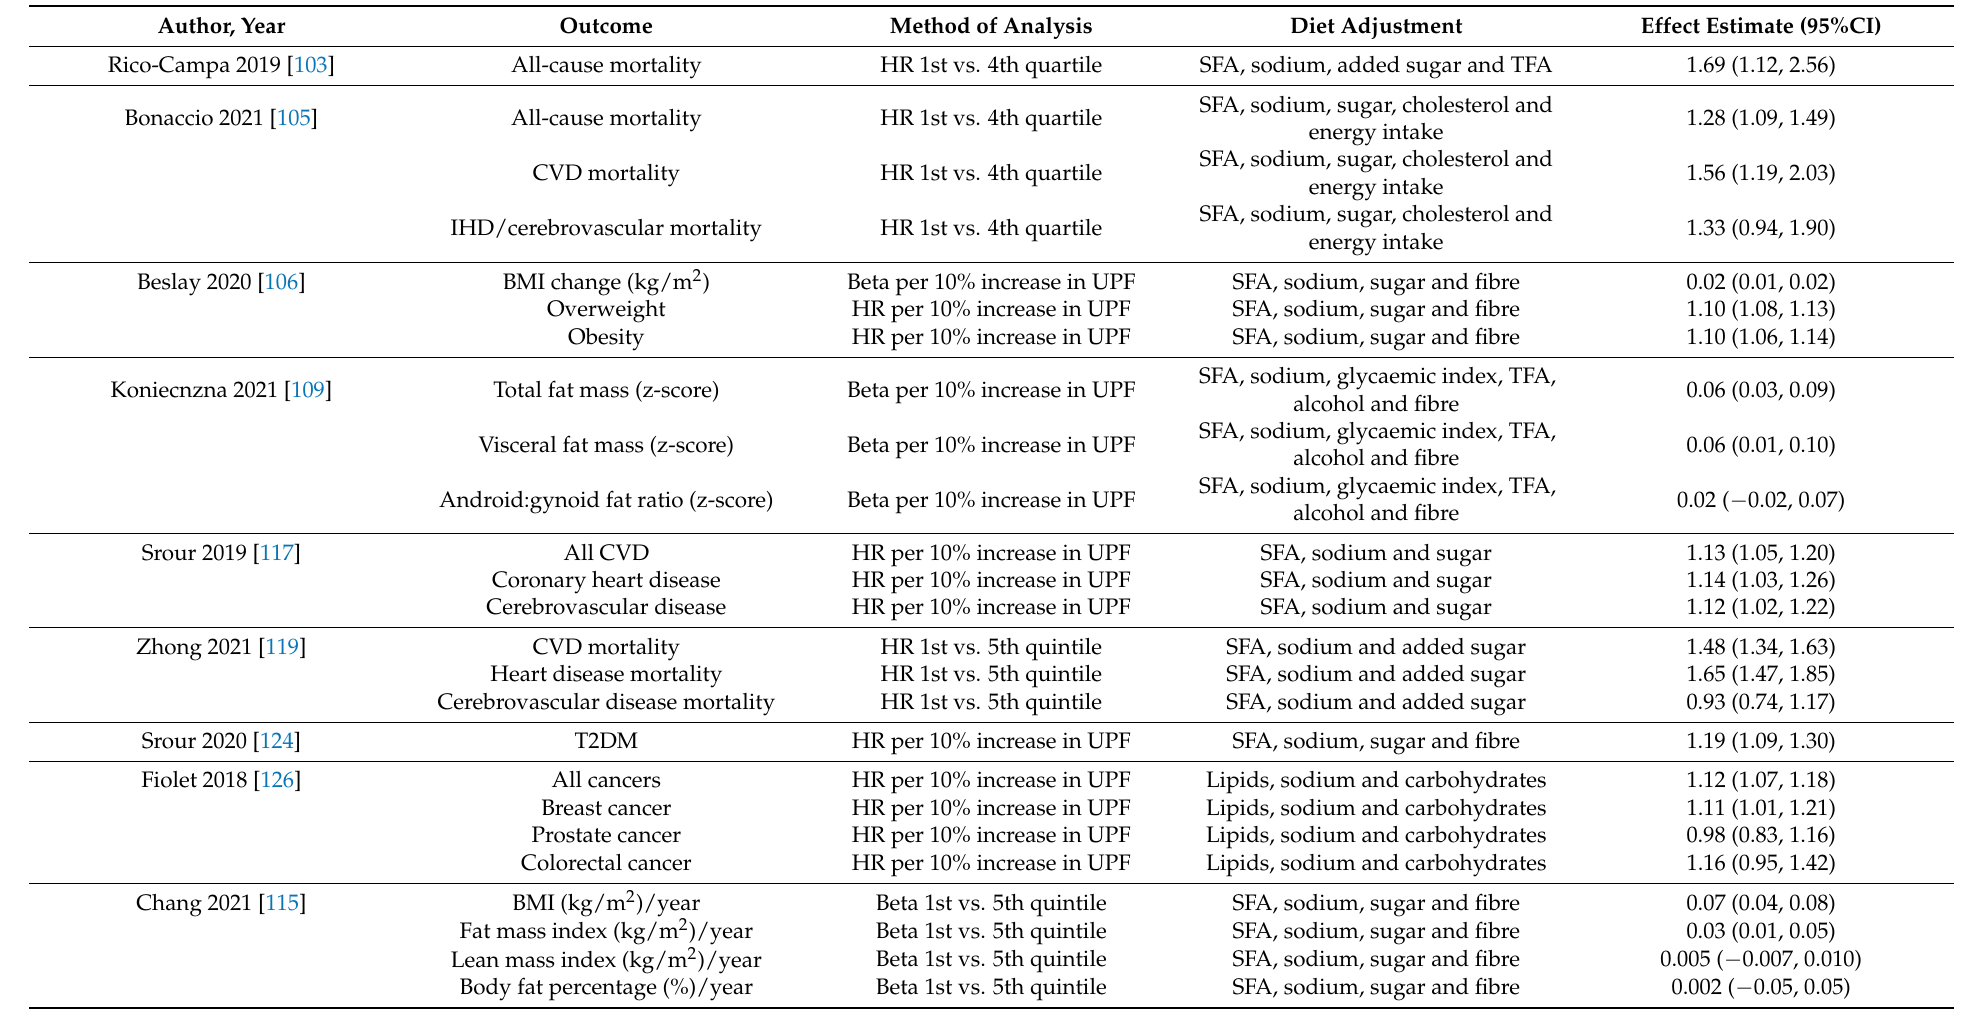
Table 3. Prospective studies adjusting for fat, added sugar/carbohydrate and sodium